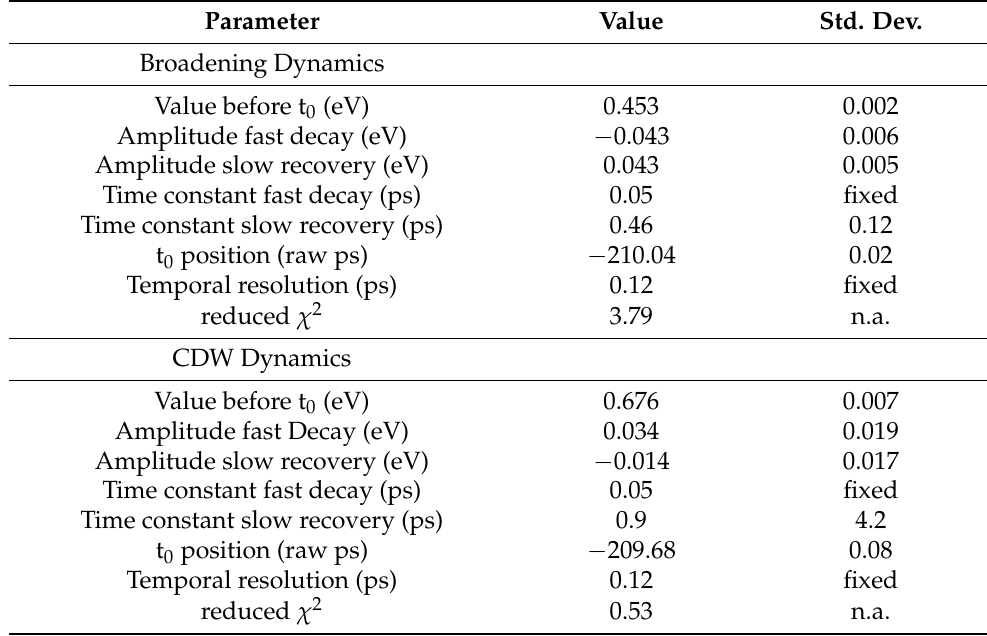
Table 3. Fitting results of the femtosecond CDW and Gaussian broadening dynamics.